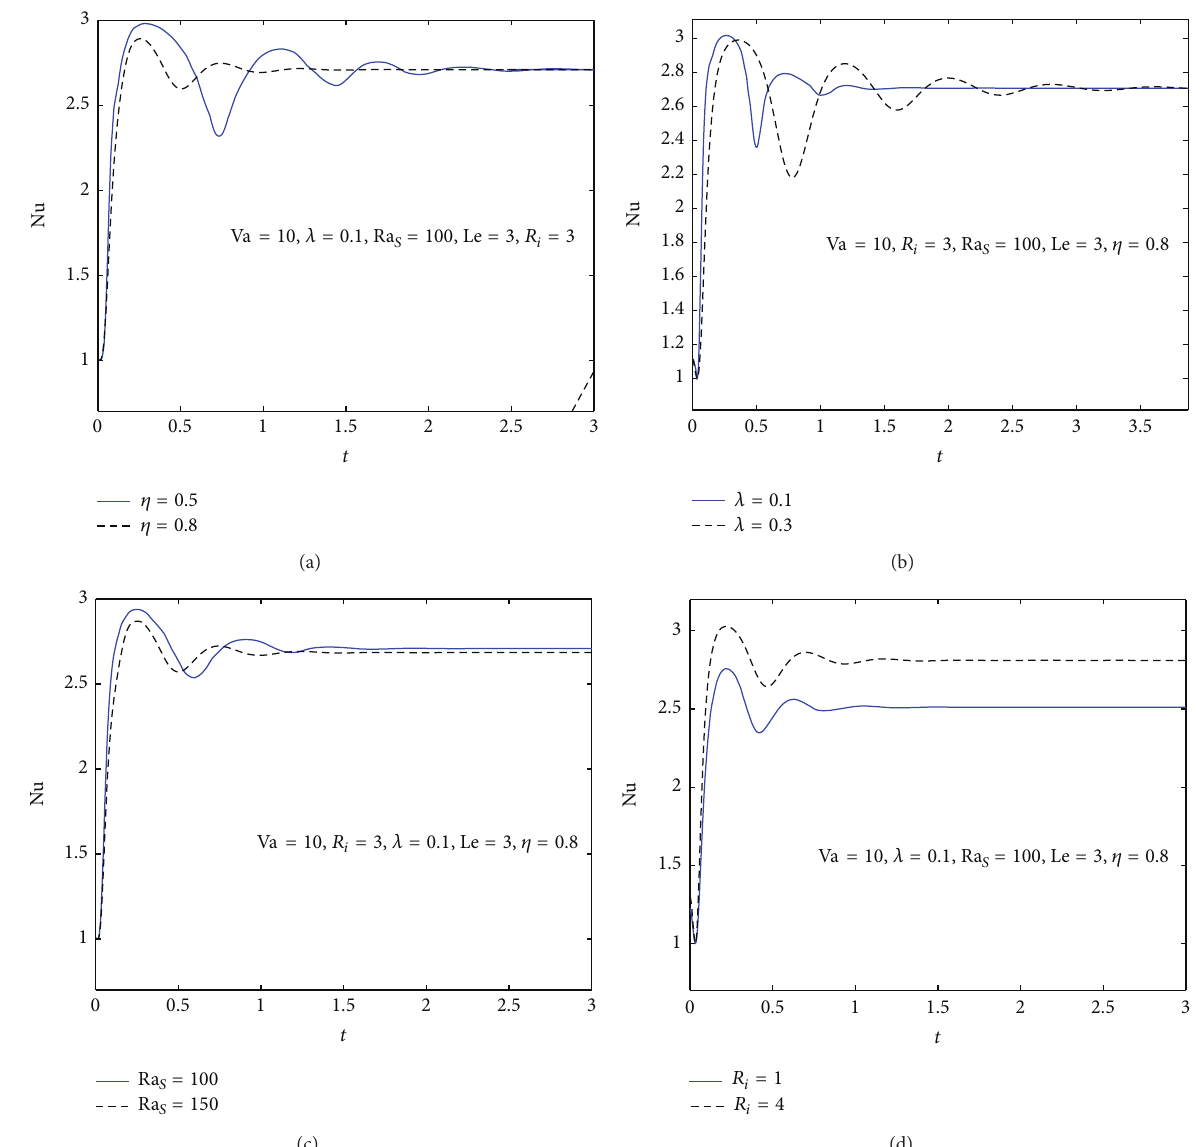
Figure 3: Variation in Nusselt number Nu with respect to time 𝑡 for unsteady nonlinear stability at different values of parameters.